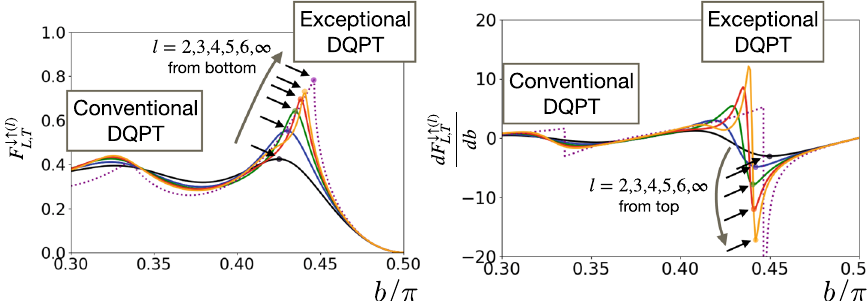
Fig. 4 Generalized correlation function and correlation/oscillation lengths ξ cor , ξ osc corresponding to F Tr different values of b for L = 500. In the antiunitary symmetry (AUS) unbroken phase ( b < b c ≃ 0.0257 π ), the correlation decays exponentially. In the AUS broken phase ( b > b c ), the correlation exhibits oscillatory long-range order. b Divergence of ξ cor (solid line) and ξ osc (dotted line) in the thermodynamic